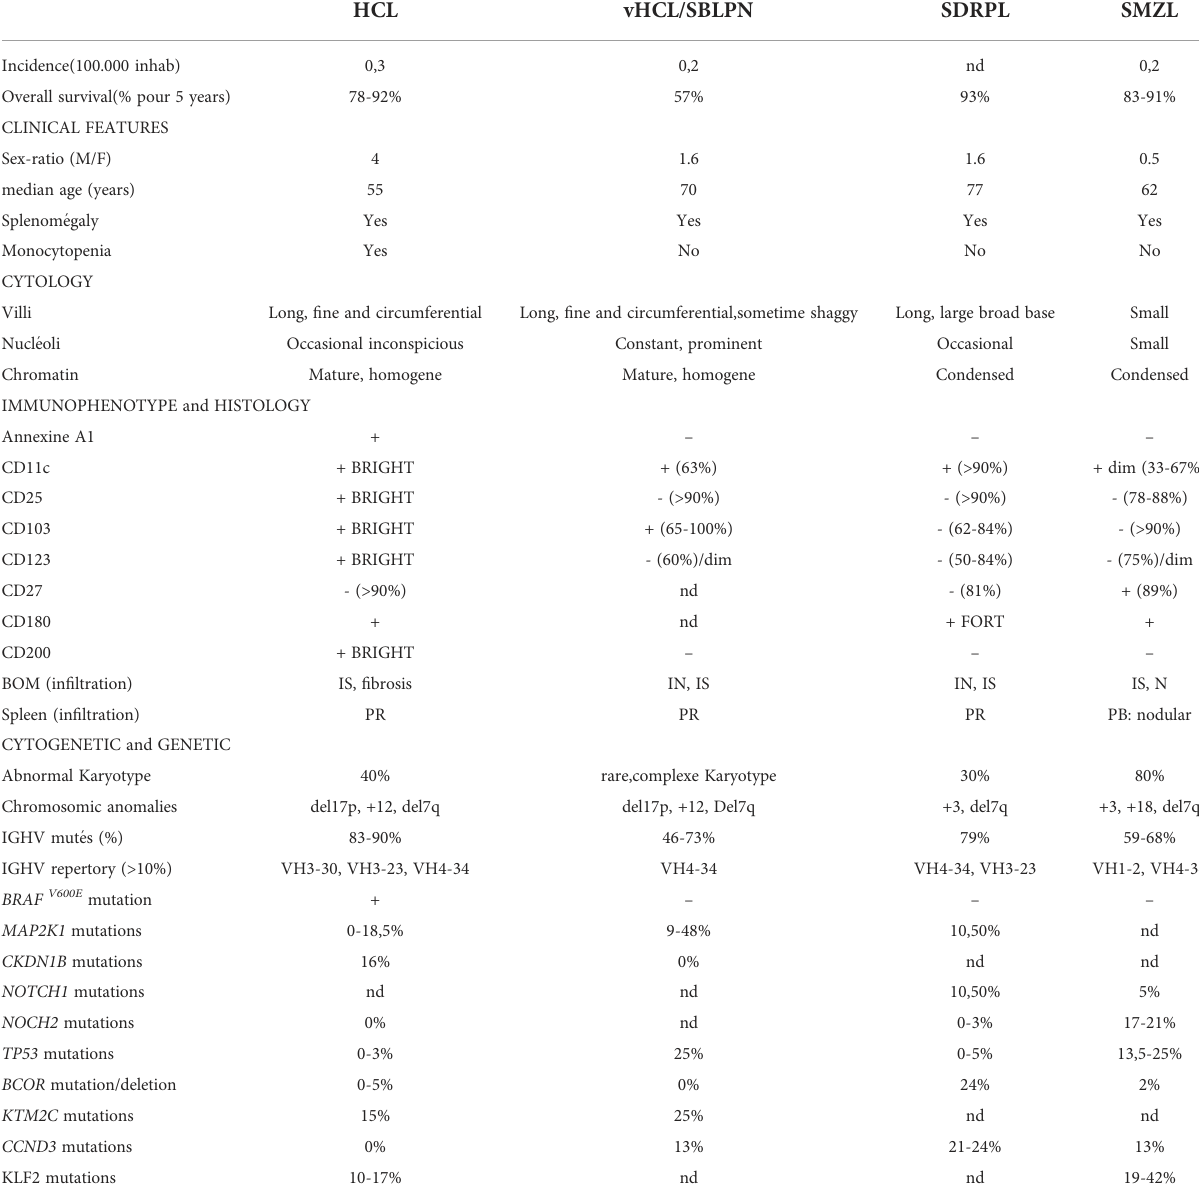
TABLE 1 Characteristics of hairy cell leukemia (HCL) and HCL-like disorders.